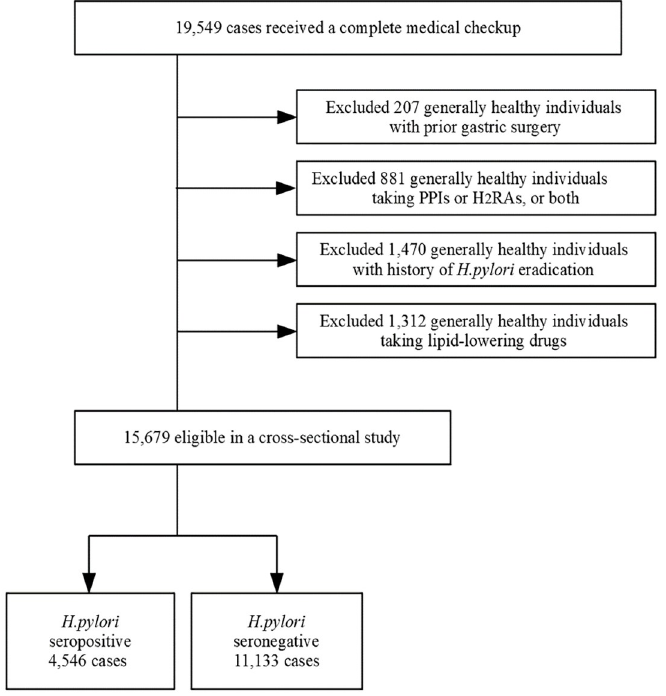
Fig 1. Study recruitment flowchart. Of the 19,549 general population participants, we excluded participants with prior gastric surgery (207), those taking proton pump inhibitors and/or histamine 2 receptor antagonists (881), those with a history of H . pylori eradication (1,470), and those taking lipid-lowering drugs (1,312). Among the eligible 15,679 participants, the numbers of participants positive and negative for serum Helicobacter pylori IgG antibody are shown.